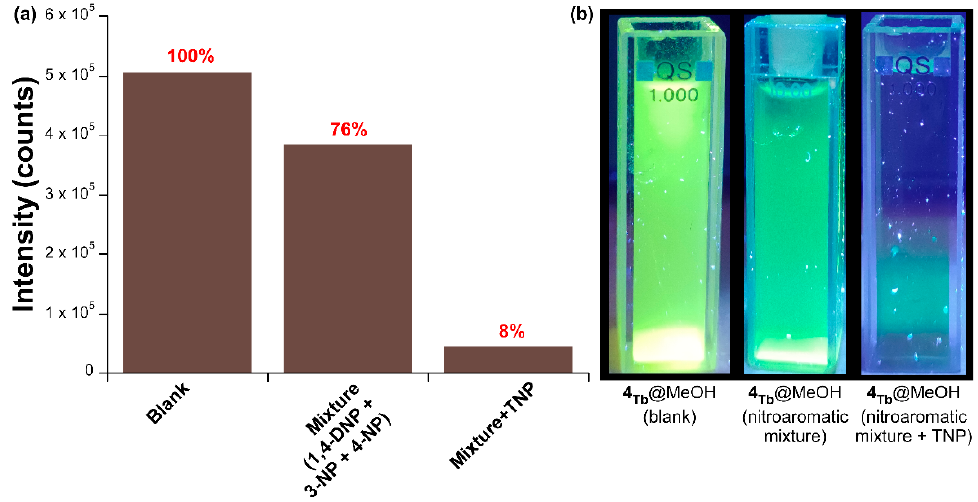
Figure 8. Comparison of the luminescent emission of 4 Tb @MeOH in the absence or presence of ni- troaromatic molecules: ( a ) as a bar chart and ( b ) photographs of the irradiated suspension.